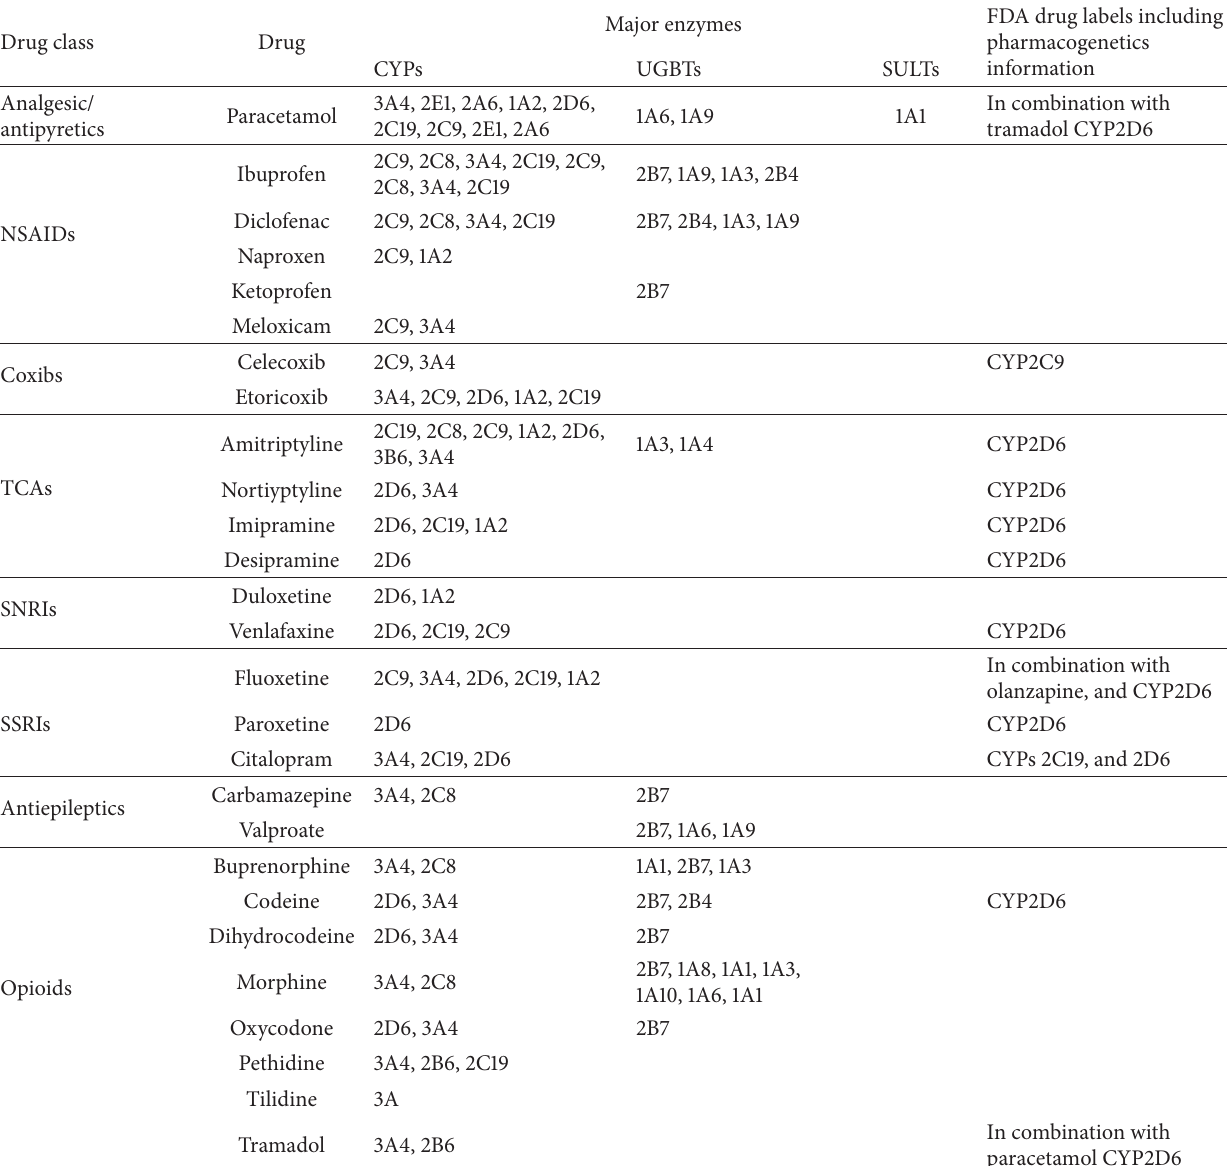
Table 5: Drugs used in pain treatment and its major DMEs emphazing FDA recommendations for genetic testing [73–75]. Drug class